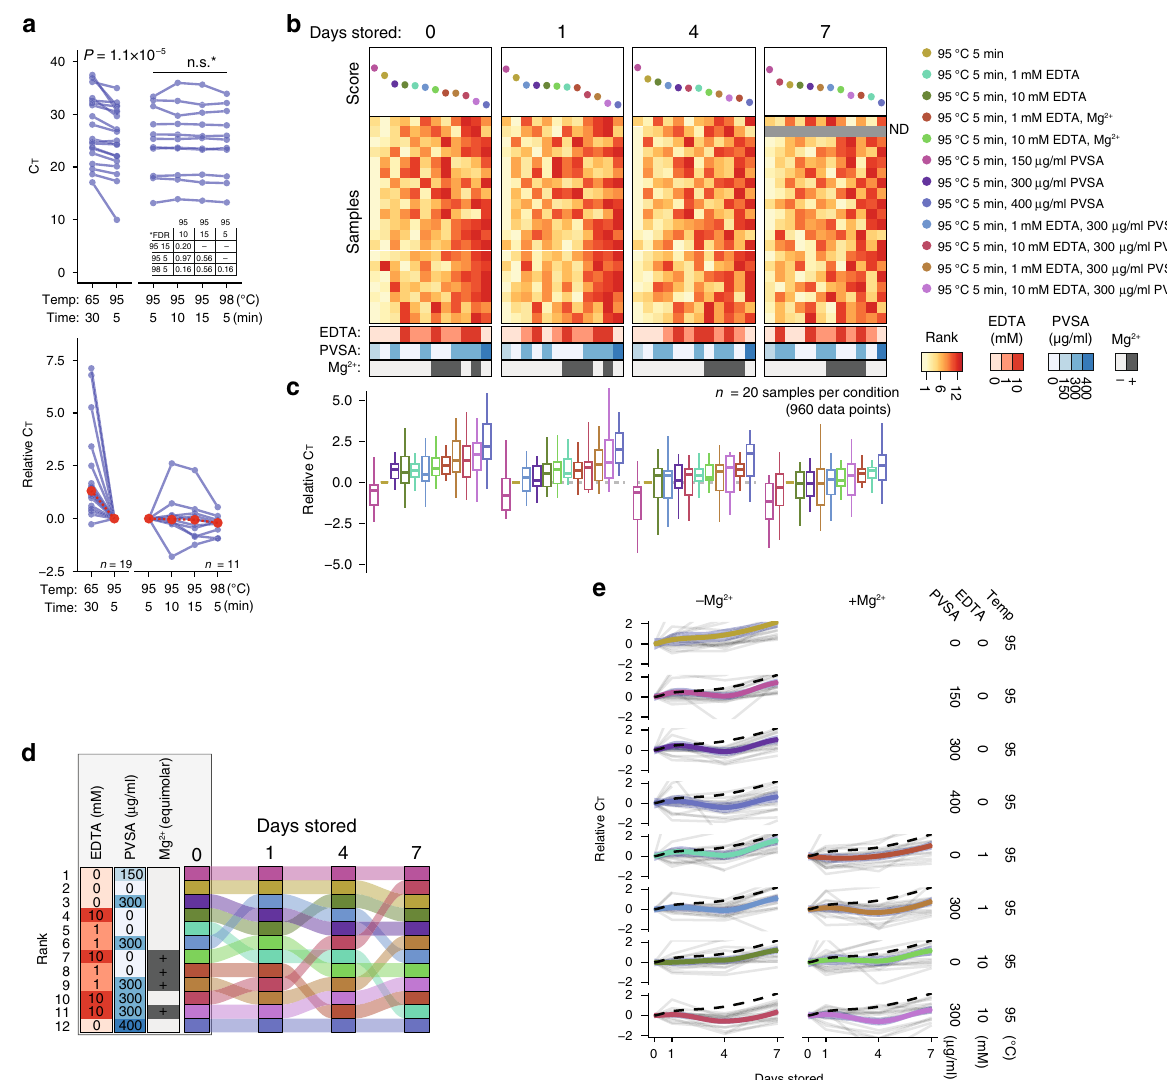
Fig. 3 Optimisation of heat-inactivation conditions for SARS-CoV-2 hid-RT-PCR. a C T values for aliquots of nasopharyngeal swab samples inactivated at different temperature and time conditions, shown on absolute scale (left) and C T change relative to the 95 °C 5 min condition (right). P -values calculated as two-tailed Wilcoxon signed rank tests. *FDR corrected for multiple testing. Median values shown in red. b Heatmaps of ranks based on absolute C T values for nasopharyngeal swab samples ( n = 20) with or without addition of polyvinylsulfonic acid (PVSA) and/or ethylenediaminetetraacetic acid (EDTA) before performing heat inactivation at 95 °C for 5 min. For EDTA-containing samples, equimolar supplement of MgCl 2 was added to the RT-PCR reaction as indicated. The same samples were evaluated by RT-qPCR repeatedly at different number of days stored at 4 °C after the heat activation. All conditions are listed in Table 2. c Boxplots of C T values relative to the 95 °C condition without additives, ordered by the rank in (b). Center lines denote the median, hinges denote IQR and whiskers denote outlier points at maximum 1.5 × IQR. d Change in rank over days of storage at 4 °C. Colors and order same as in ( b , c ). Annotations refer to samples stored for 0 days. e Change in C T values over days stored at 4 °C across different conditions. Thick line and ribbon indicate fi tted LOESS curve and ±95% con fi dence interval, respectively. The dashed line indicates the 95 °C (without additive)